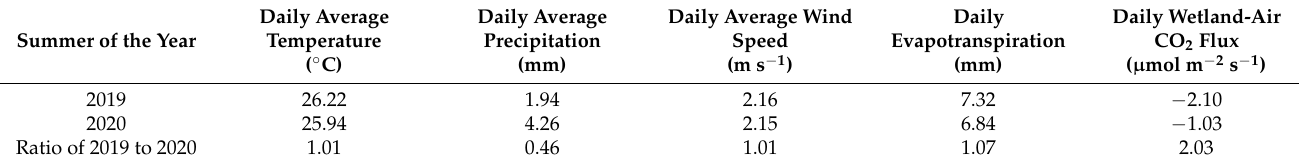
Table 2. Daily average meteorology and wetland-air CO 2 flux at the Baiyangdian Lake (BYDL) in the summers of 2019 and 2020.